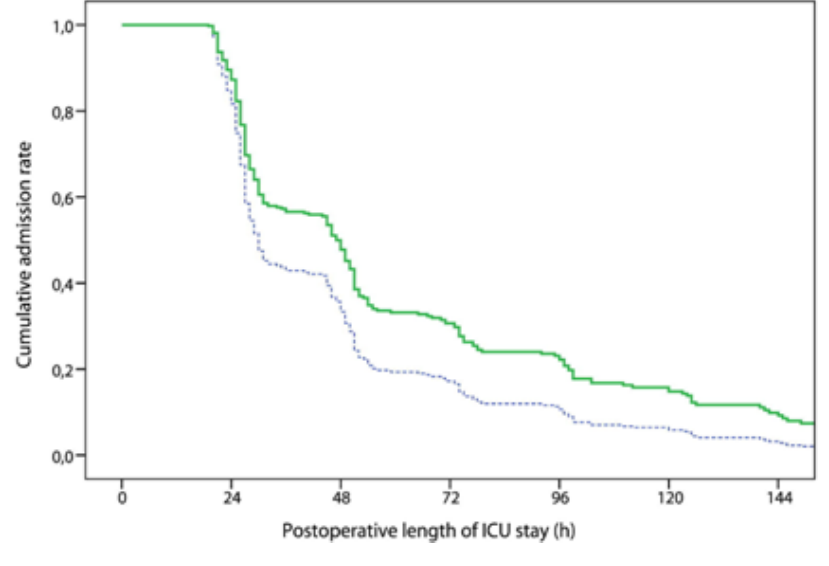
Figure 2. Postoperative admission rates to the intensive care unit among patients undergoing cardiac surgery with low fat-free mass index (green line) and without low fat-free mass index (blue dotted line). This figure is reproduced with permission from [38], Copyright © The American Association for Thoracic